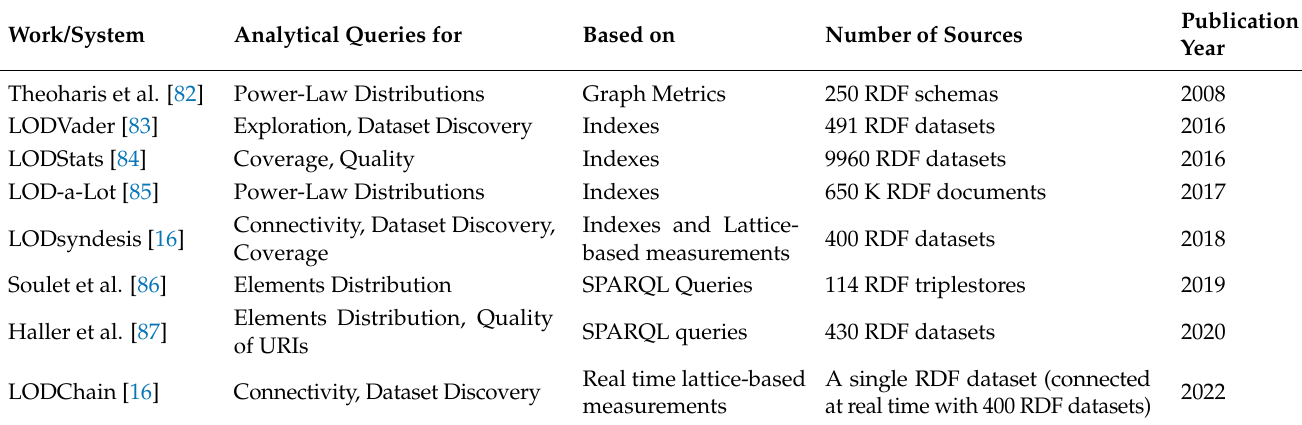
Table 4. Overview of the introduced Works of Category C5 (supporting analytical queries of Category